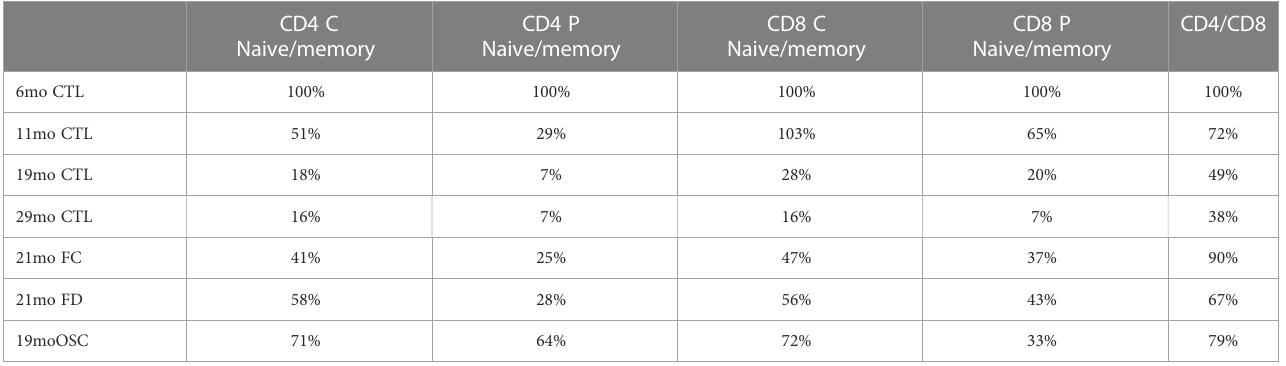
CTL, control mice; FC, transplanted with follicle-containing young 60d ovaries at 13mo of age; FD, transplanted with follicle-depleted young 60d ovaries at 13mo of age; OSC, transplanted with isolated young 60d ovarian somatic cells at 13mo of age.